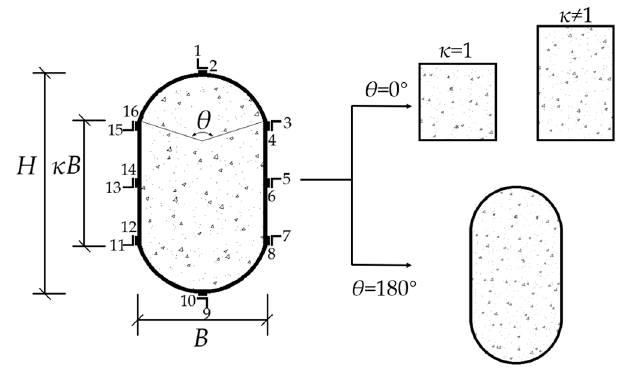
Figure 1. Cross-section of an RRCFST.